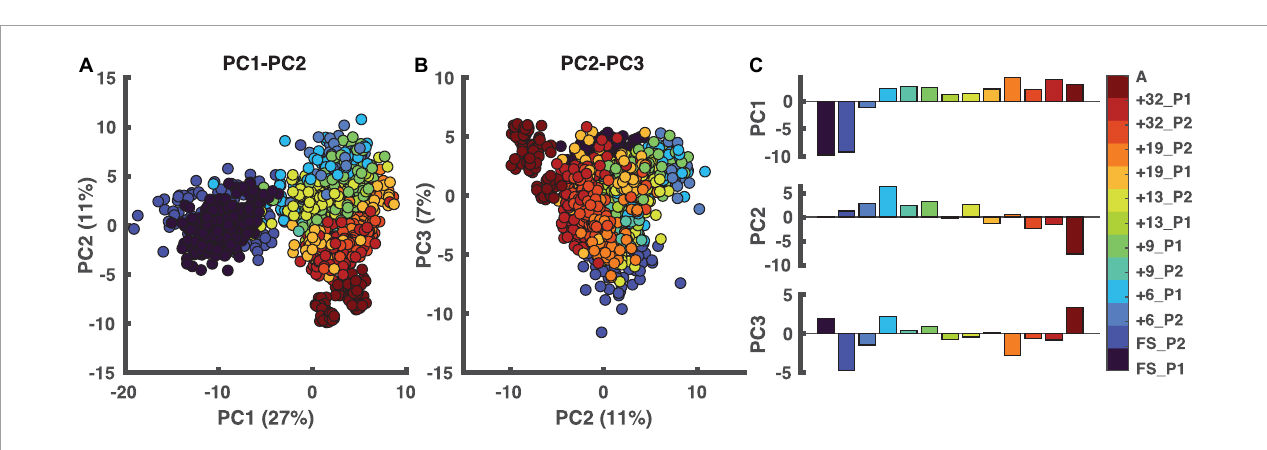
FIGURE3 Principal component analysis (PCA). In the two left panels, each dot represents one stride. (A) PCA results in PC1-PC2 space. (B) The outcome of the PCA in PC2-PC3 space. (C) The weightings of all sessions ordered based on walking age, so not ordered per participant. PC1 distinguishes the FS sessions from the other sessions with PC2 distinguishing “mature” from “immature” running. A: adults, PC: principal component, FS: first steps, +6, +9, +13, +19, +32 refers to the number of months since onset of independent walking.